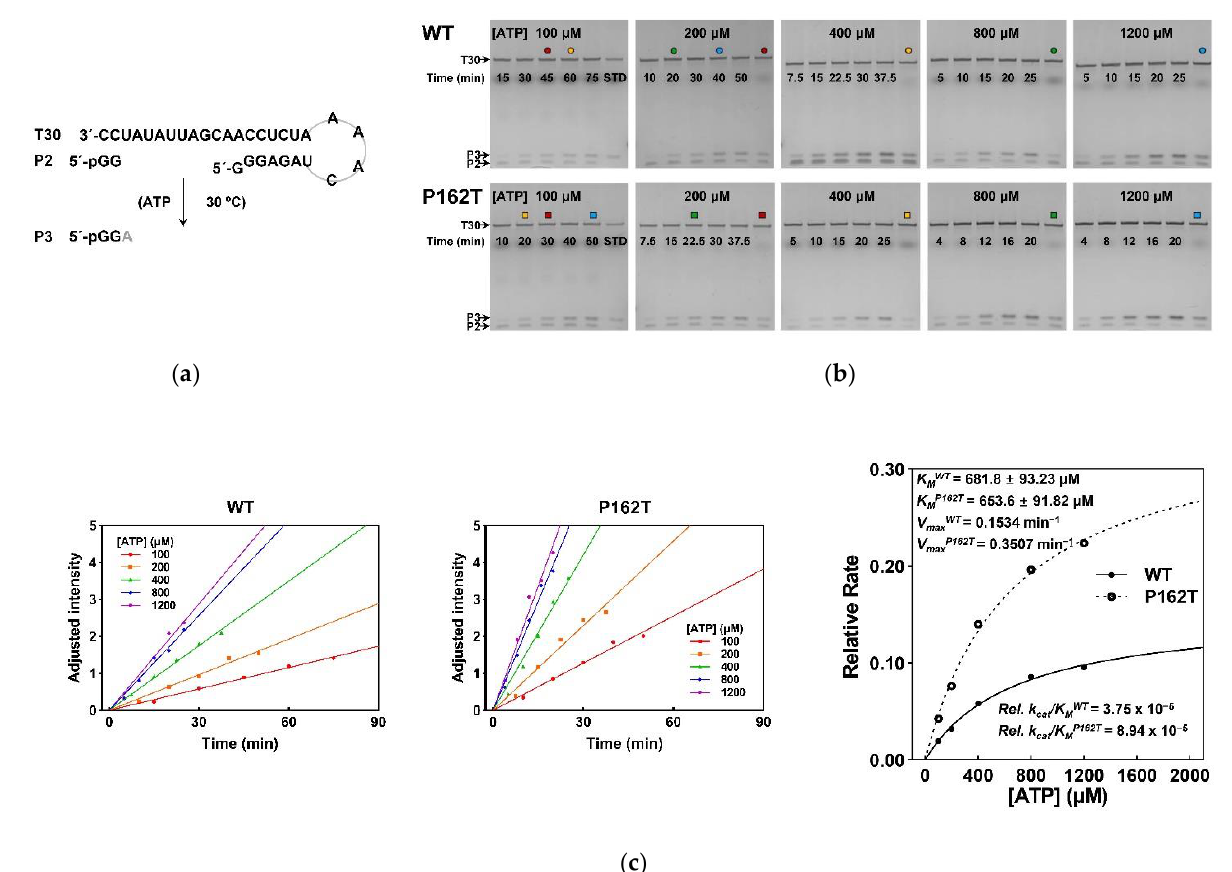
Figure 6. Characteristics of the initiation kinetics on NS5B WT and NS5B P162T . ( a ) Schematic diagram of the P2 to P3 conversion assay. ( b ) Denaturing urea-PAGE analysis of the P3 formation under different ATP concentrations by NS5B WT and NS5B P162T constructs. The lanes marked with same color-coded icons represented the banks from the same sample which was used to correlate band intensity in different gels. STD, standard sample containing P3 from the pre-experiment. ( c ) Comparison of the initiation efficiency for NS5B WT and NS5B P162T . The relative reaction rates of NS5B WT and NS5B P162T constructs were estimated by the equation about the adjusted intensity of the P3 as a function of time at five ATP concentrations. The rate values were then fit to the Michaelis – Menten equation to generate the Michaelis constant ( K M ), relative maximum reaction rate ( V max ), and relative specificity constant ( k cat /K M ).